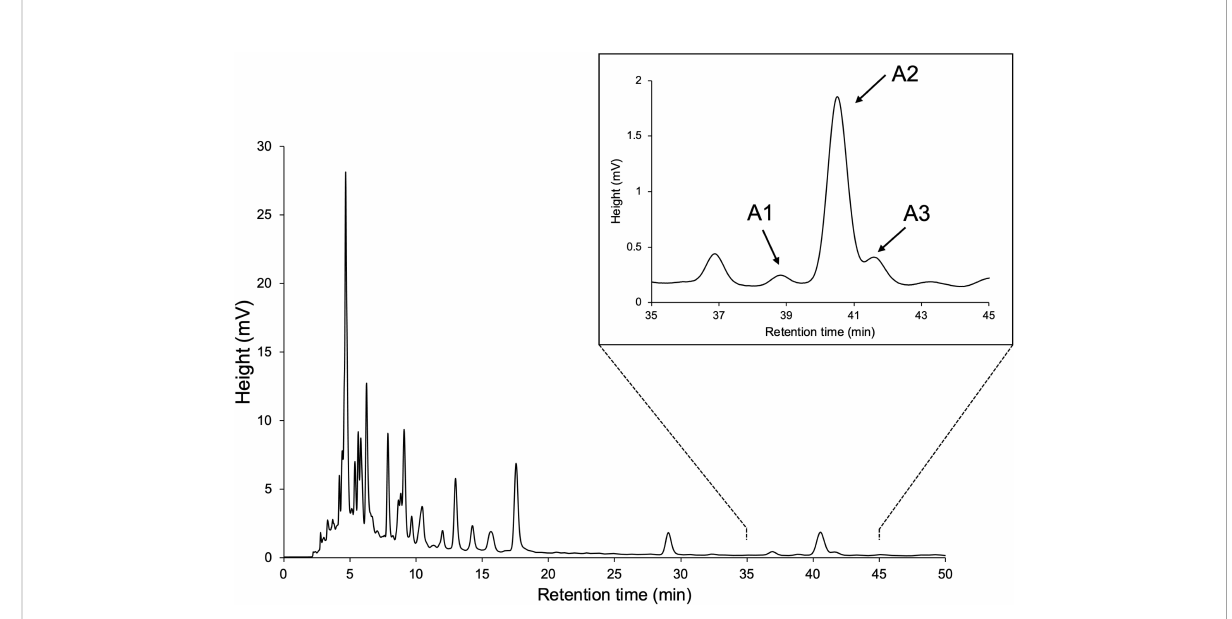
FIGURE 2 HPLC separation of SL-like compounds (A1, A2, and A3) with the same molecular mass as